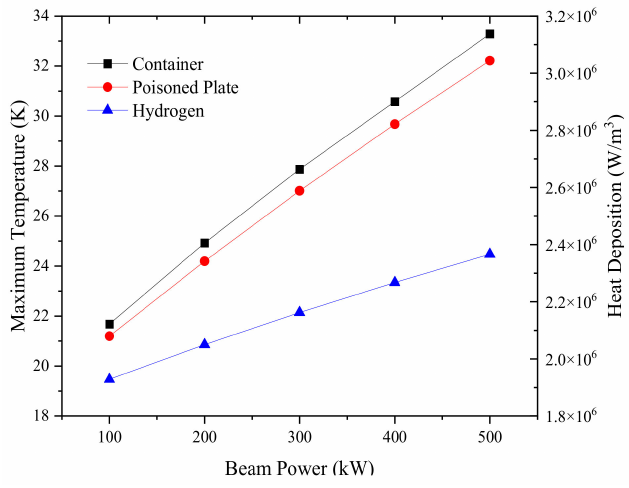
Figure 8. The variation of maximum temperature with different beam